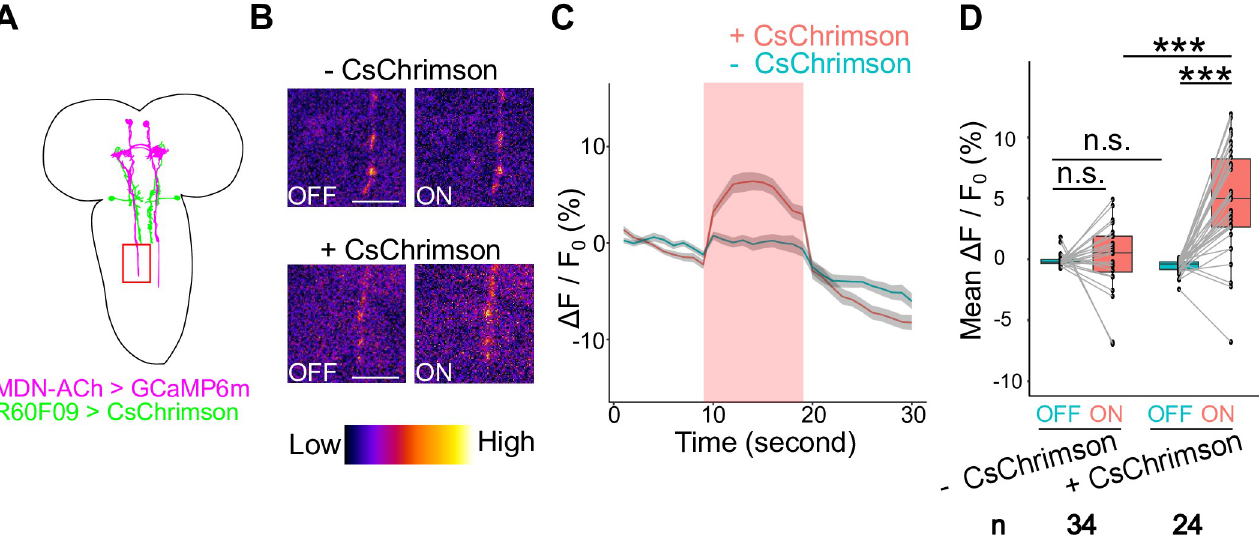
Fig 6. Optogenetic AMB activation causes Ca 2+ responses in MDNs. (A) A schematic view of AMBs and MDNs. The red box indicates the area observed in Ca 2+ imaging. (B) Ca 2+ imaging of MDNs upon optogenetic activation of AMBs in with (lower panels) or without CsChrimson (upper panels) conditions. Here are shown representative images of relative Ca 2+ levels 5 seconds before (OFF) and after (ON) light application. Scale bars, 10 μ m. (C) Time series of calcium responses in MDN axons upon optogenetic AMB activation. Red light was applied during the period indicated by the red band. Larvae harboring CsChrimson, n = 24; Larvae without CsChrimson, n = 34; Data are shown as the mean ± SEM. Genotypes: w ; UAS-GCaMP6m , tsh-GAL80/R60F09-LexA ; R73F04-GAL4 , Gad1-2A-GAL80 / LexAop-CsChrimson ( +CsChrimson ); w ; UAS-GCaMP6m , tsh-GAL80 /+; R73F04-GAL4 , Gad1-2A-GAL80 / LexAop-CsChrimson ( -CsChrimson ). (D) Average of MDN Δ F/F 0 values in 10 seconds before (OFF) or during (ON) optogenetic activation. In the boxplot, the width of the box represents the interquartile range. The whiskers extend to the data point which is less than 1.5 times the length of the box away from the box, and the dot represent outlier. We assessed statistical significance by Welch ‘s t test with Holm method. ��� p < 0.001.